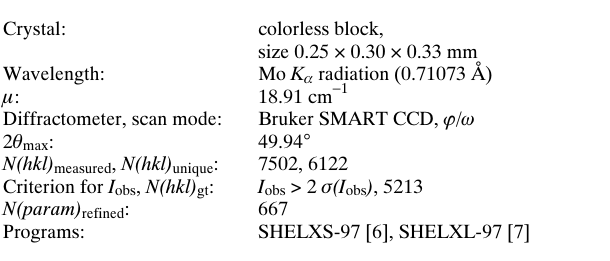
Table 1. Data collection and